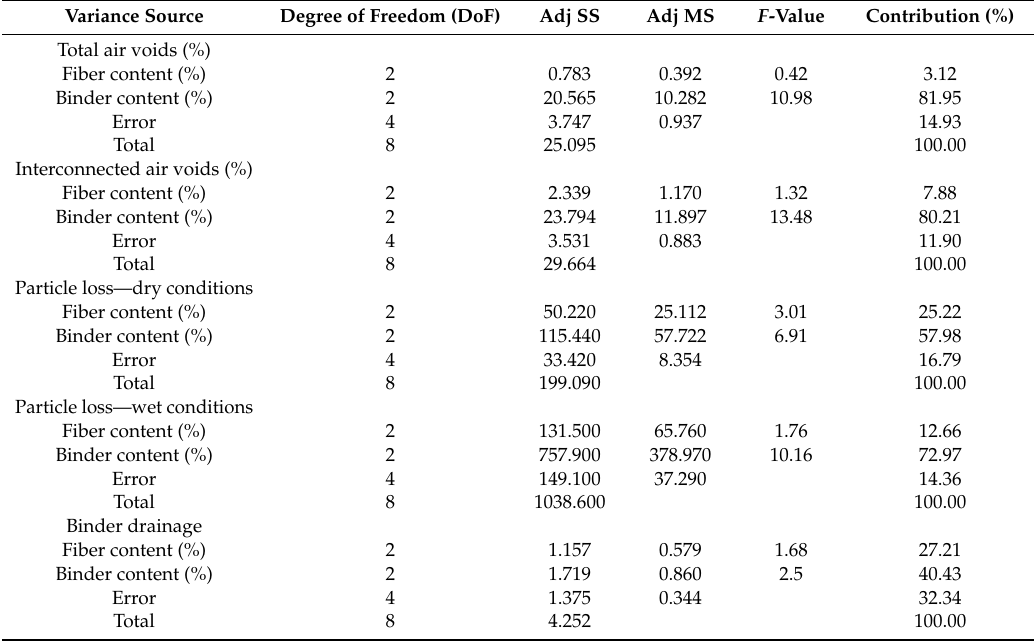
Table 7. Analysis of variance for T AV , I AV , PL DRY , PL WET and BD